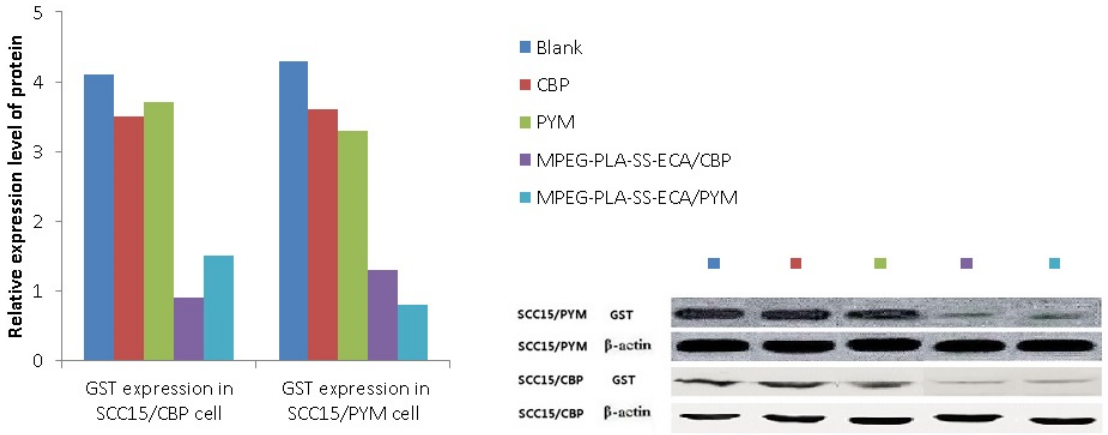
Figure 6. Expression levels of GST protein in drug resistant